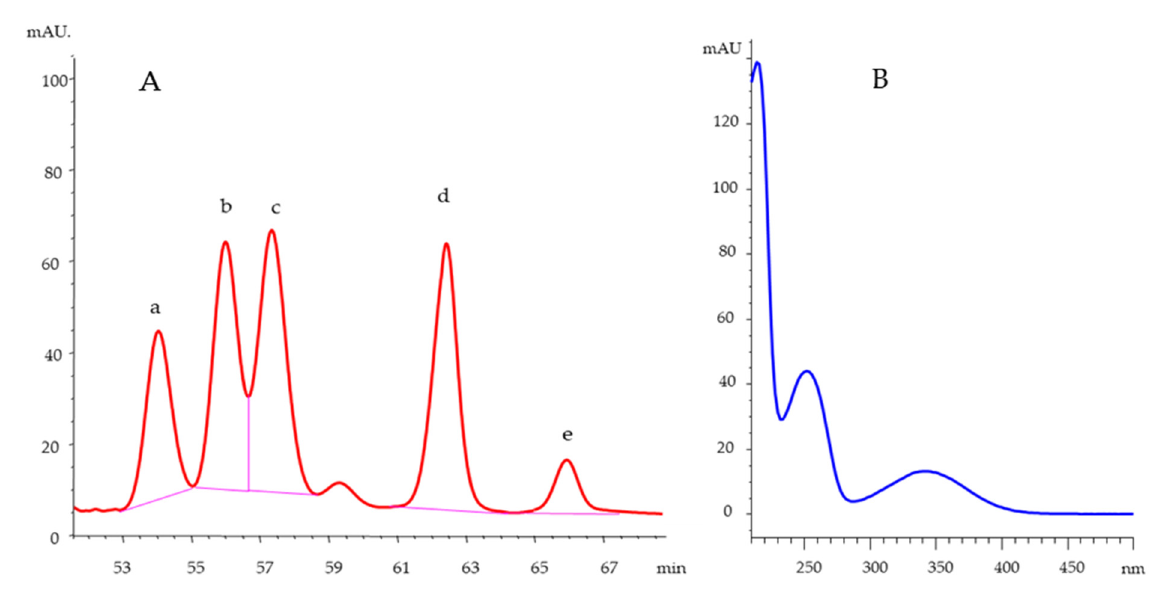
Figure 3. ( A ) Chromatogram of phytosterols standard solution at 100 mg/L: a for cycloartenol, b for campesterol, c for stigmasterol, d for β -sitosterol, and e for hexacosanol (internal standard); ( B ) UV spectrum of derivatized phytosterols.